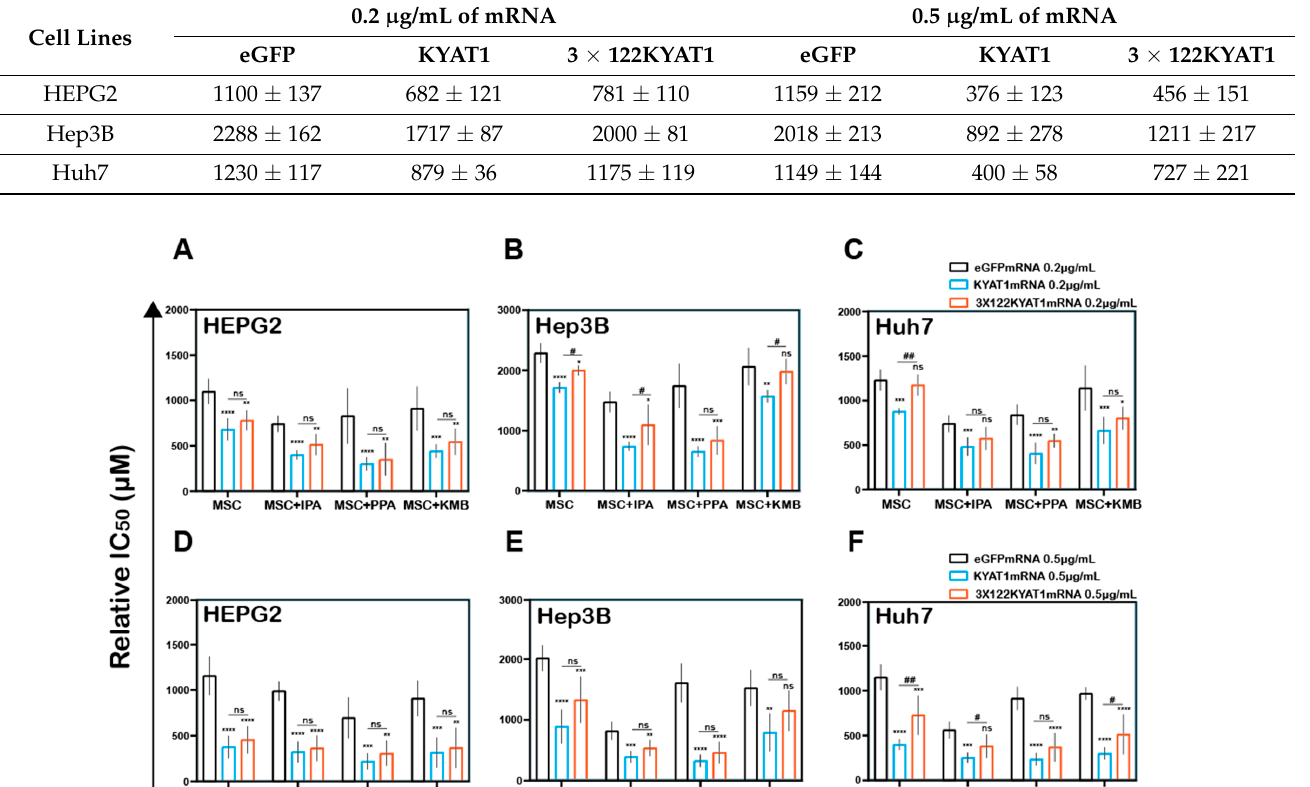
Table 2. Relative IC 50 values of MSC at 72 h in HEPG2, Hep3B, and Huh7 cells transfected with 0.2 µ g/mL and 0.5 µ g/mL of eGFPmRNA, KYAT1mRNA, and 3 × 122KYAT1mRNA. Results are represented as mean ± SD from triplicate measurements from at least five independent experiments. Resultant IC 50 values are denoted in µ M.